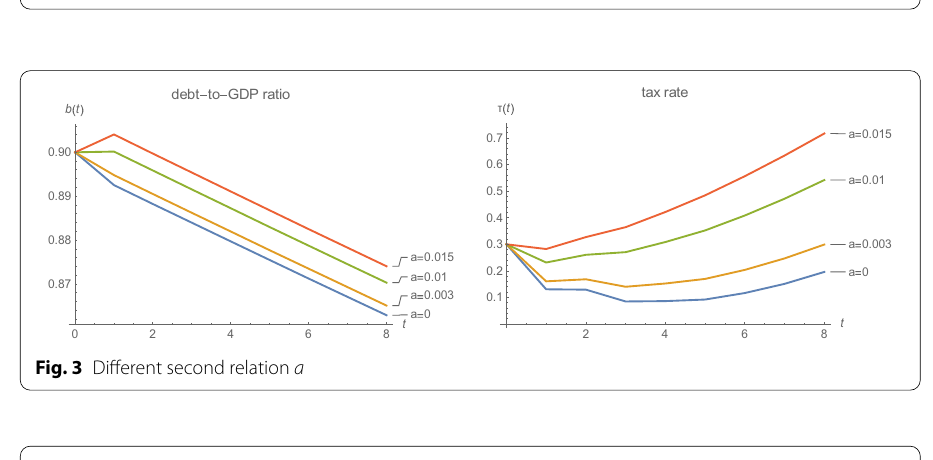
Fig. 2 Different accelerator v